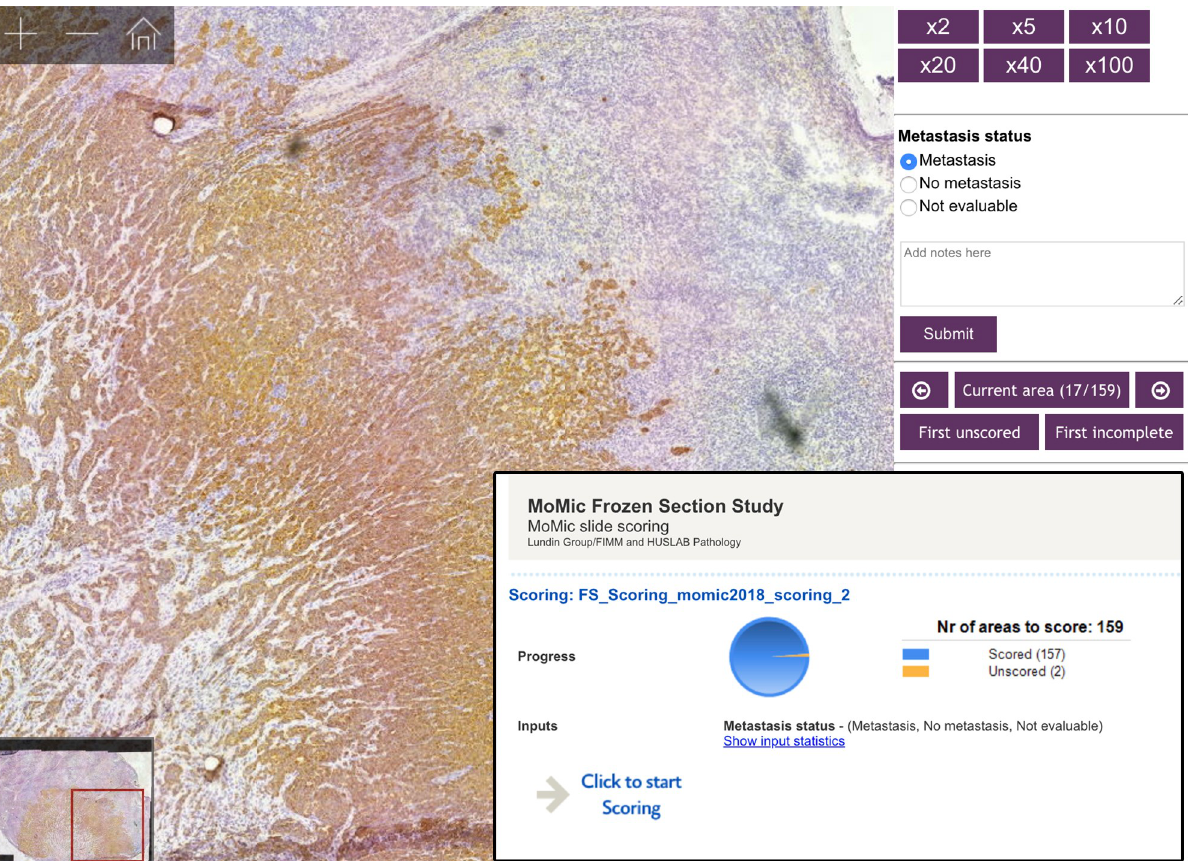
Fig 3. Online image management platform and slide scoring questionnaire. Image showing a scanned lymph node frozen sections (digitized with the miniature microscope scanner) and viewed on the slide management platform with the scoring questionnaire.